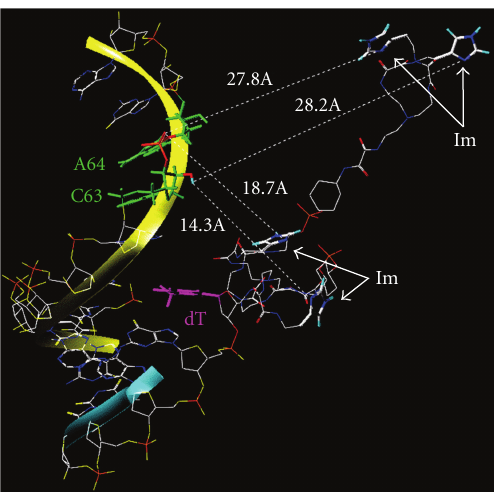
Figure 6: A fragment showing one possible conformation (namely, final structure F9-Im(4/2a)) of B-Im(4/2a) (4a) found for the hybrid complex H-Im(4/2a). Distances between the cleaving groups and the sequence C 63 -A 64 (green) are indicated. The dT (magenta) semistacking interaction with the dG 1 fragment is also shown. Hydrogen atoms have been removed for easier visualization.